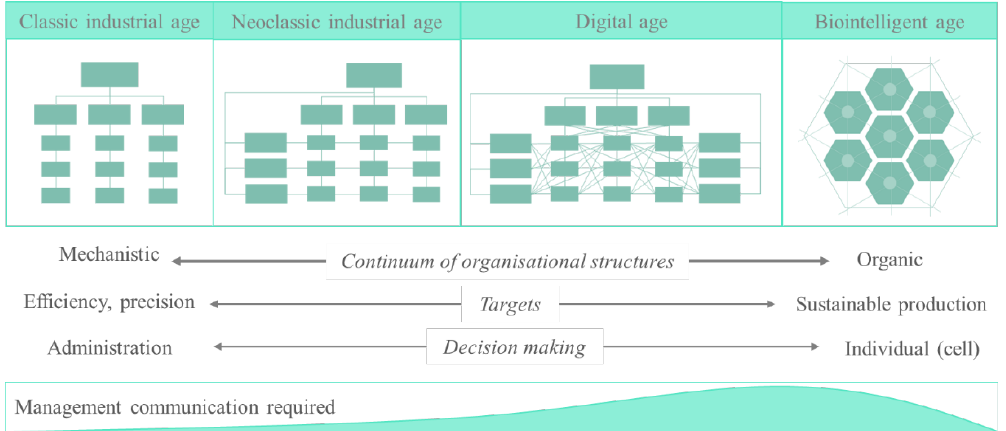
Figure 8. Biointelligent organizational structure in comparison to existing industrial structures (own illustration based on [39]).